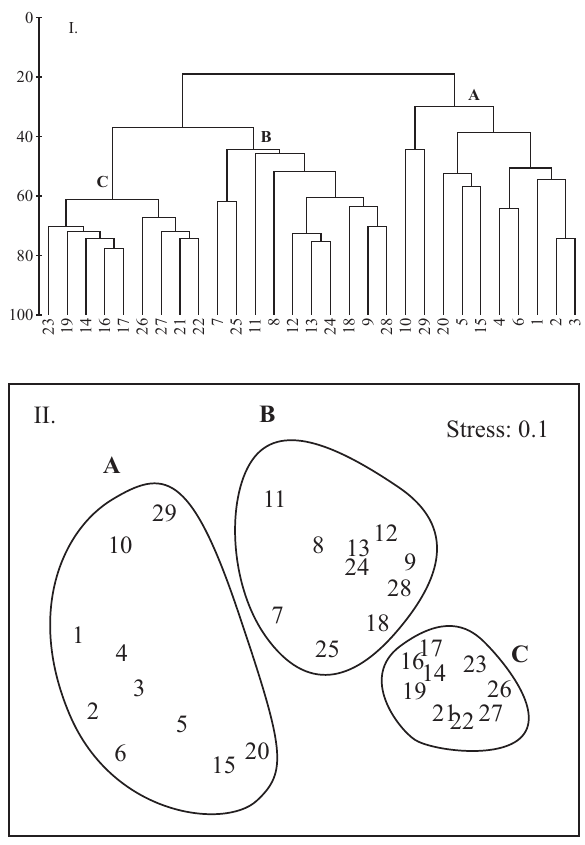
Fig . 2. – Dendrogram (i) and MDs (ii) using bray-Curtis similarity coefficient showing the classification and ordination of